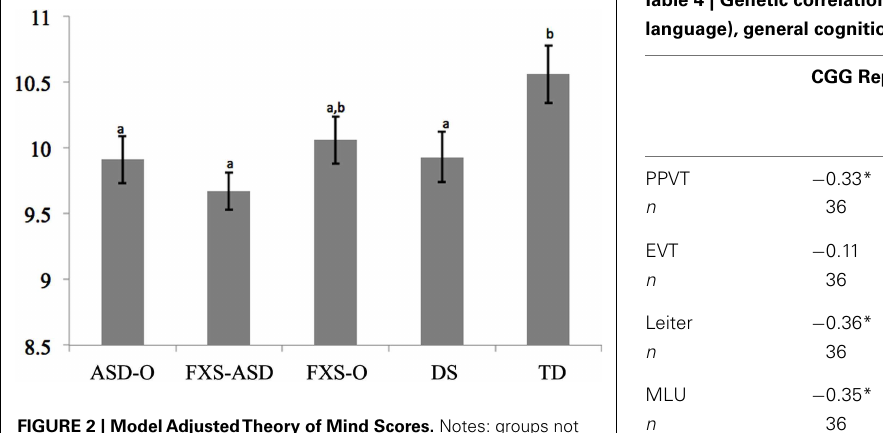
FIGURE 2 | ModelAdjustedTheory of Mind Scores. Notes: groups not sharing superscripts are significantly different from each other ( p < 0.05). F for Diagnosis (4, 106) = 2.87, p < 0.05.